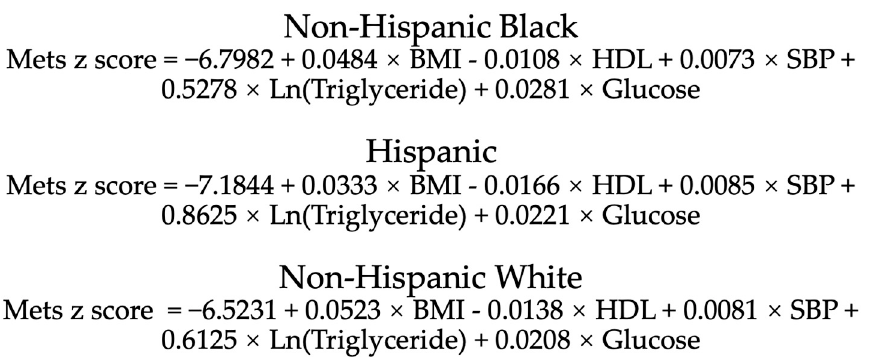
Figure 2. Calculation formula of MetS BMI z-score for female of different races. BMI, body mass index; HDL, high density lipoprotein; SBP, systolic blood pressure. BMI: kg/m 2 ; HDL, triglyceride, glucose: mg/dl; SBP: mmHg.